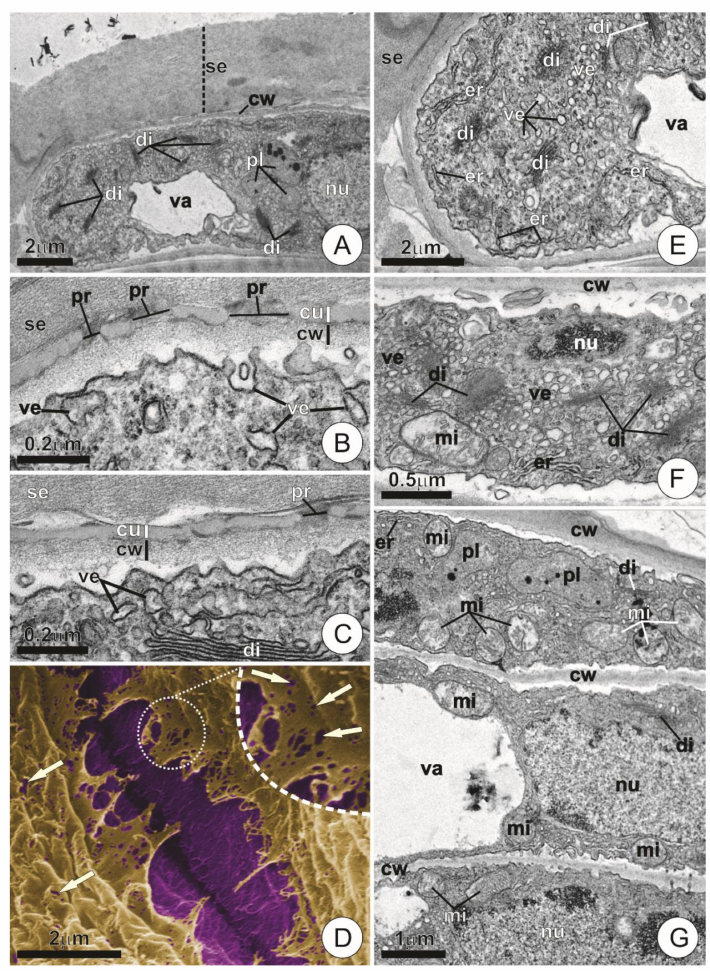
Figure 4. Ultrastructure of wing cells in young trichomes. ( A ) Longitudinal section of a wing cell. Note the dense cytoplasm and the thick layer of secretion on the cell surface. ( B , C ) Detail of the cell wall and protoplast. Note the presence of pores in the cuticle and small vesicles in contact with the plasmalemma. ( D ) Scanning electron micrograph showing the contact region between adjacent wing cells. Artificial coloring highlights the cell wall (purple) and the cuticle (ruptured, in yellow). Note the presence of cuticular pores (arrows). ( E – G ) Overview of wing cell protoplasts. Note the dense cytoplasm with numerous vesicles, dictyosomes, and mitochondria. (cu = cuticle; cw = cell wall; di = dictyosome; er = endoplasmic reticulum; mi = mitochondria; nu = nucleus; pl = plastids; pr = pore; se = secretion; va = vacuole; ve =